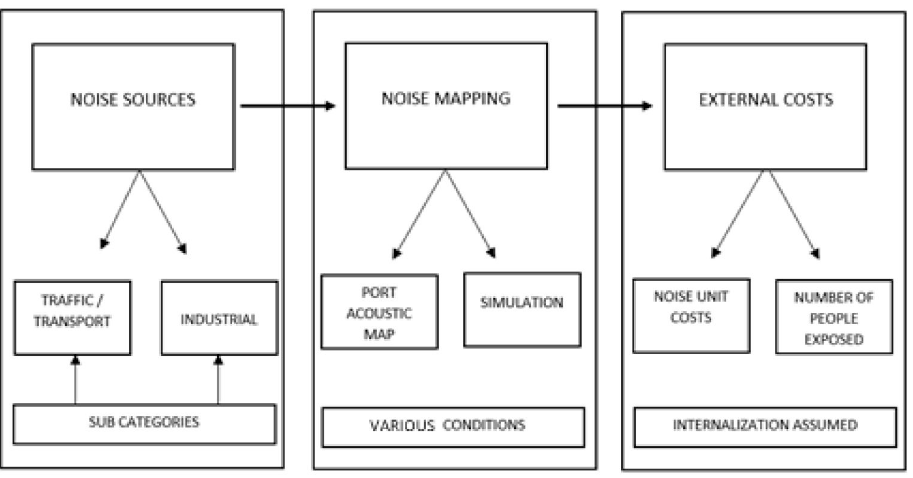
Figure 1. Flowchart of the